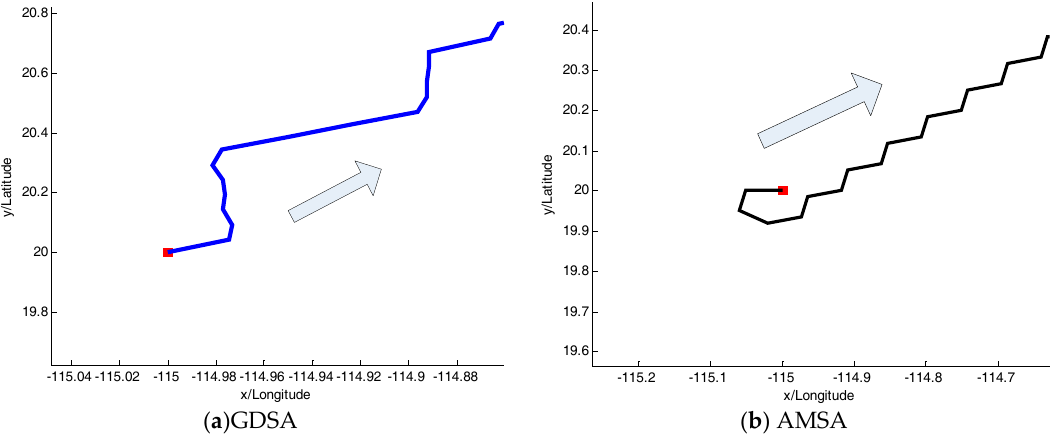
Figure 9. The beginning of two algorithms.